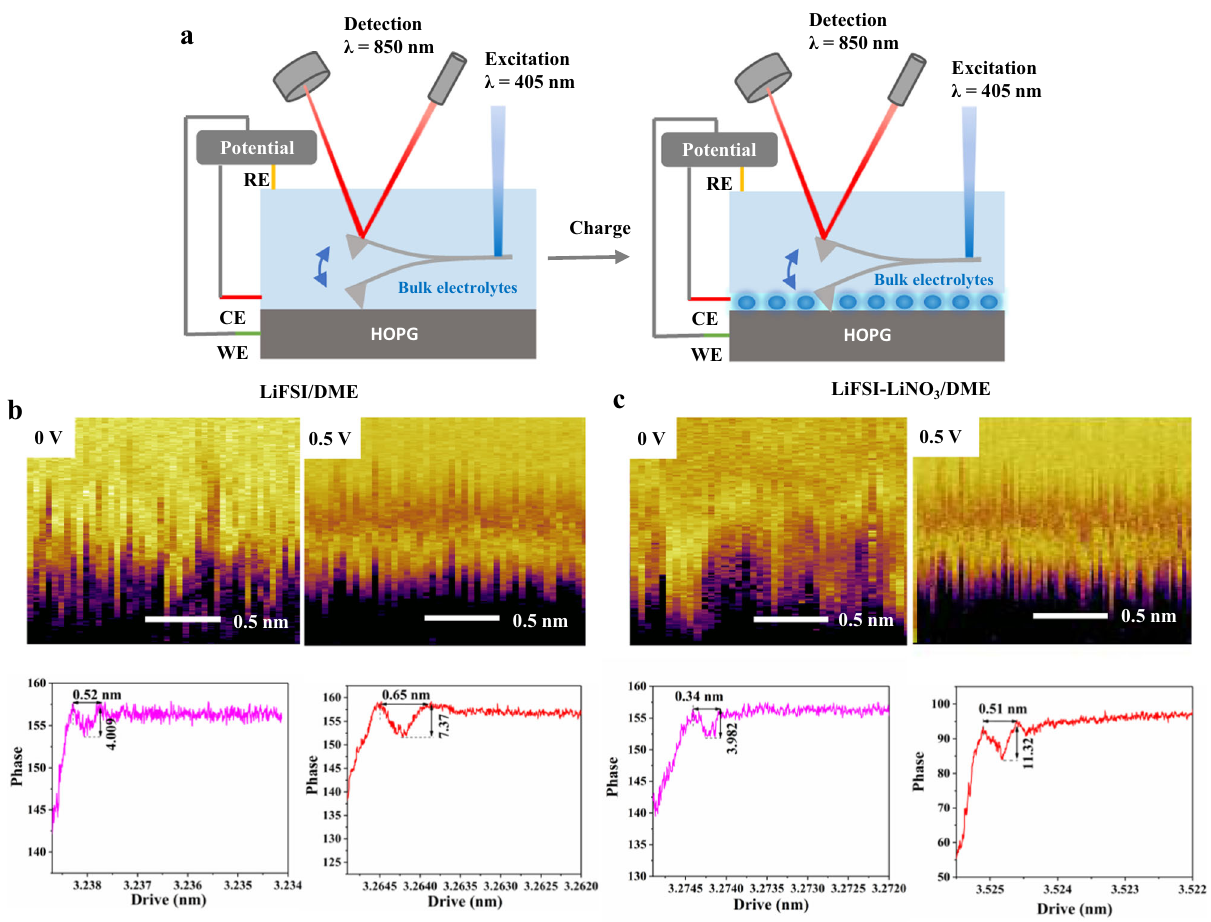
Fig. 7 In situ EC-AFM characterization of EDL structure under different voltages. a Schematic of an in situ EC-AFM cell, which was composed of a HOPG as working electrode, Ag/AgCl as reference electrode, and Pt wire as the counter electrode. The AFM cantilever is inside the liquid. Two-dimensional (2D)- AFM xz count maps HOPG – electrolytes interface at different electrode potential and corresponding Frequency shift versus distance curve in ( b ) 1 M LiFSI/ DME and ( c ) LiFSI – LiNO 3